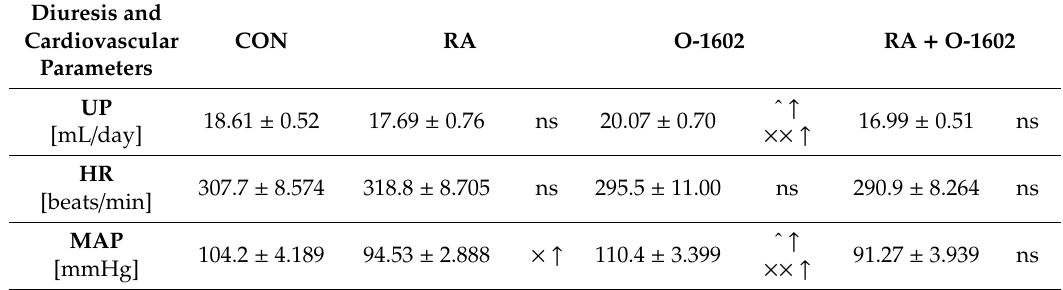
Table 2. The measurement of urine production, heart rate, and arterial pressure parameters. Diuresis